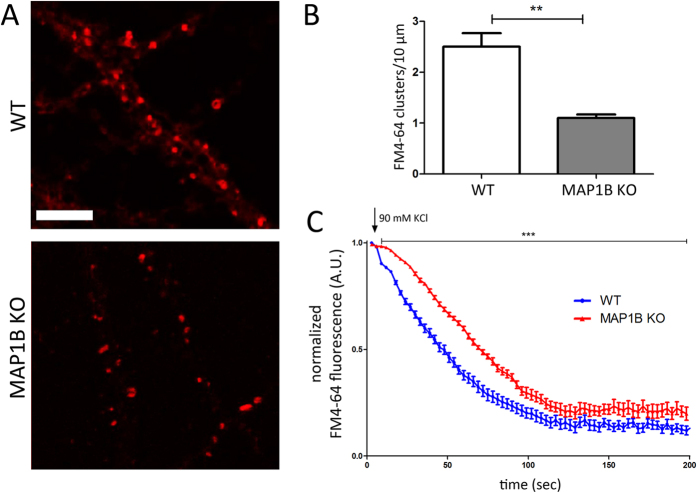
MAP1B KO neurons show delayed SV fusion events.(A) Representative images of mature neurons loaded with 10 μM of the fluorescent dye FM4-64 derived from WT (upper panel) and MAP1B KO (lower panel) mice. Scale bar 5 μm. (B) Quantification of the number of positive clusters for the FM4-64 dye (WT neurons, 2.5 ± 0.27 clusters/10 μm; MAP1B KO neurons, 1.1 ± 0.07 clusters/10 μm; unpaired Student’s t-test p < 0.01, 6091 μm analyzed for WT neurons and 6250 μm for MAP1B KO neurons. (C) FM4-64 normalized fluorescence over time graph after a depolarizing pulse of 90 mM KCl (signaled with arrow). The kinetics for WT and MAP1B KO neurons are shown with blue and red dots, respectively. All time points between 9 sec and 200 sec present statistically significant differences between genotypes, as determined by two-way ANOVA p < 0.001, n = 30 neurons per genotype.